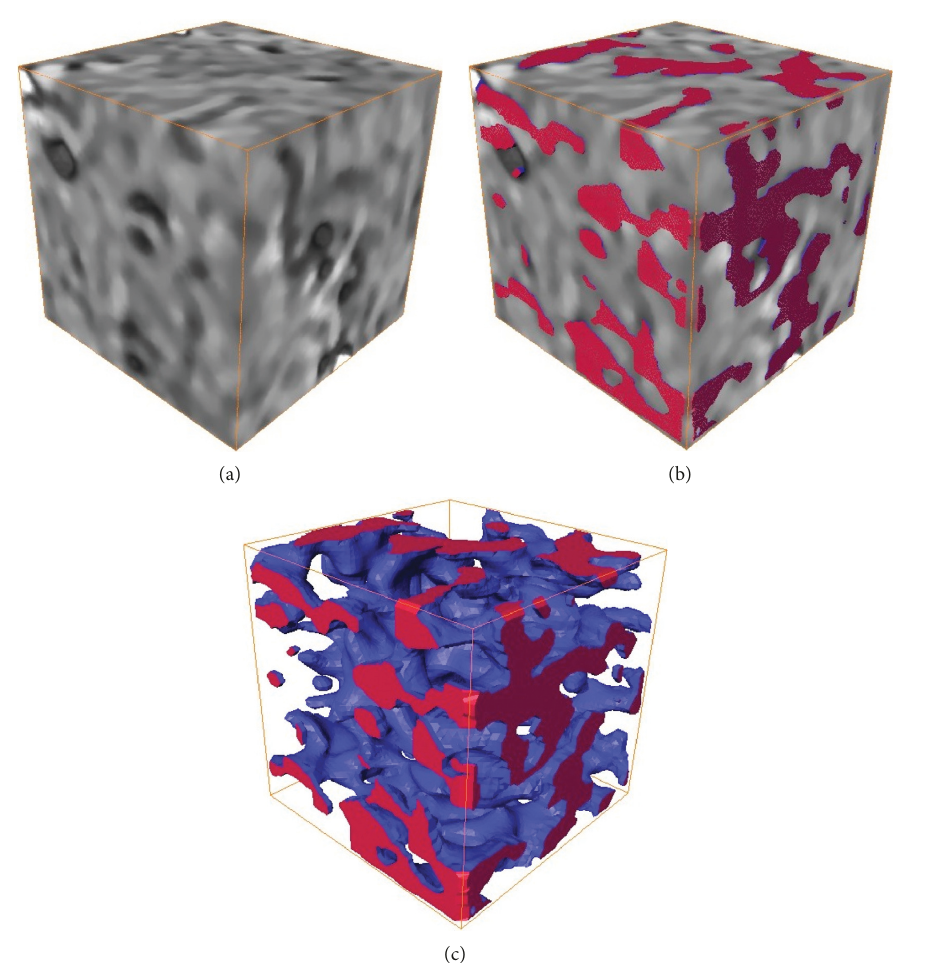
Figure 8: Model of coal’s micropore structure in model P